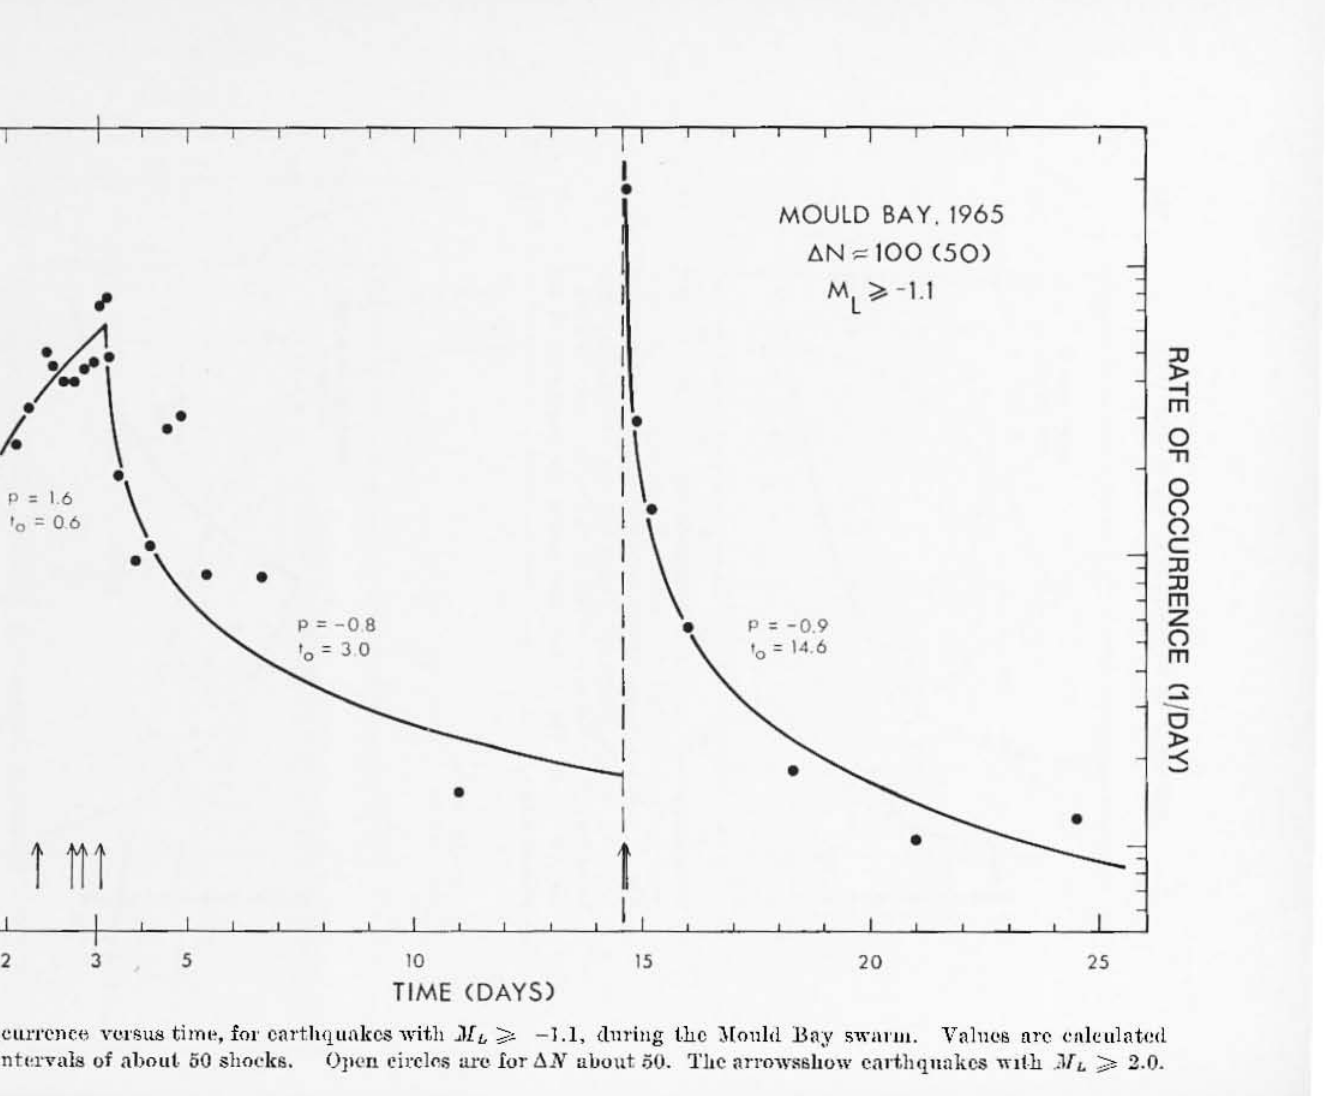
Fig. 1 l. - R:ltc of OCClll'J'l'nCO \'CI'SUS timi;, fo!' carthqunkcs with Jlt.:;,c - 1.1, dlll'illg t.hc ~[o1l1d 13ny SWlIl'IJJ. Vahws llre (~nlclllnt()d for d .N abont 100 at inb :rvals of flbout 50 shocks. OJI{'II eirclnll are forl1N auo\lt 50. Thc nrrowlIshow cll..t.h(lllokC8 wlt-h .lf l. ;>